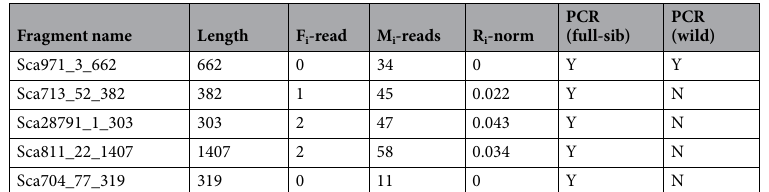
Table 3. Selected Y-linked fragments with R i -norm < 0.3, PCR results are shown in Fig. 3. Note: F i -reads is the number of female-pool aligned reads against Fragment i in male-gc-assembly, M i -reads is the number of male-pool aligned reads against Fragment i in male-gc-assembly. Thus, R i denotes the ratio that divides the F i -reads by the Mi-reads, R i -norm is the normalization of R i value, and can fairly describe the difference in the ratio of alignment reads against the reference genome between the female-pool and the male-pool. In the seventh and eighth columns, Y represents the corresponding sequence that was only amplified successfully in male individuals, and N represents the corresponding sequence that was amplified in both male and female